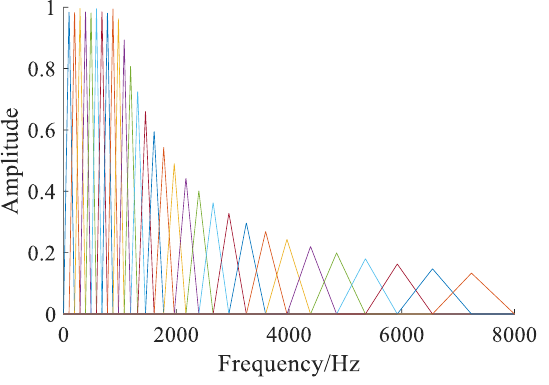
Figure 2. Mel filter bank.